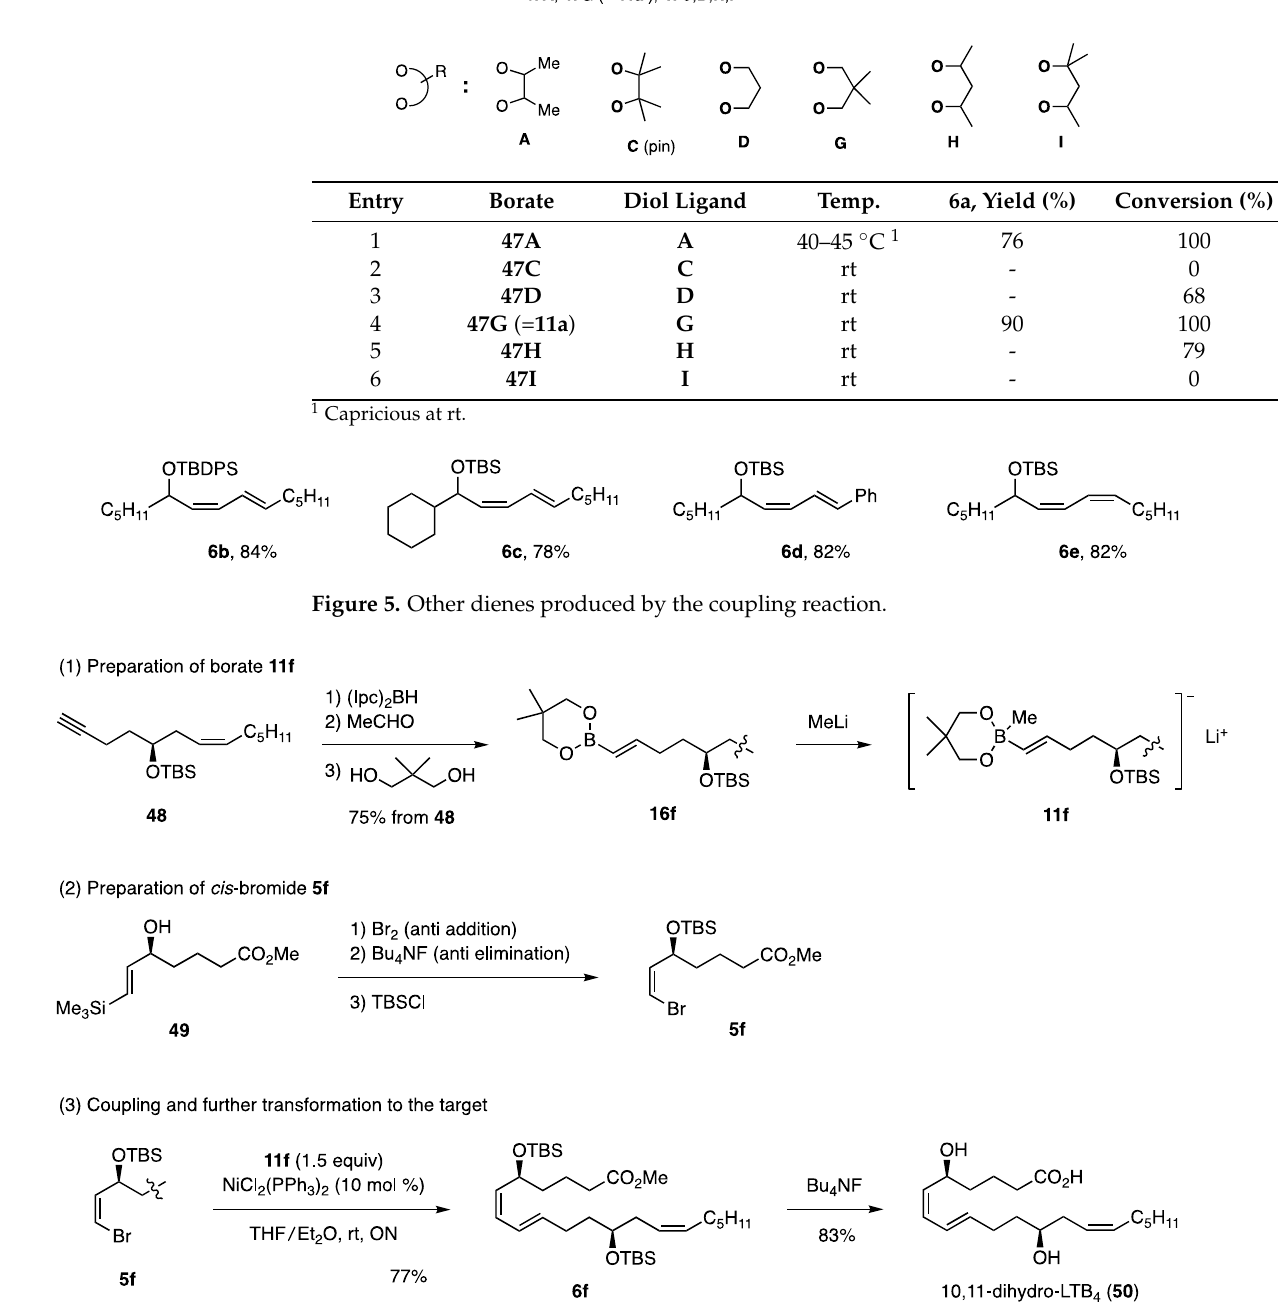
Figure 5. Other dienes produced by the coupling